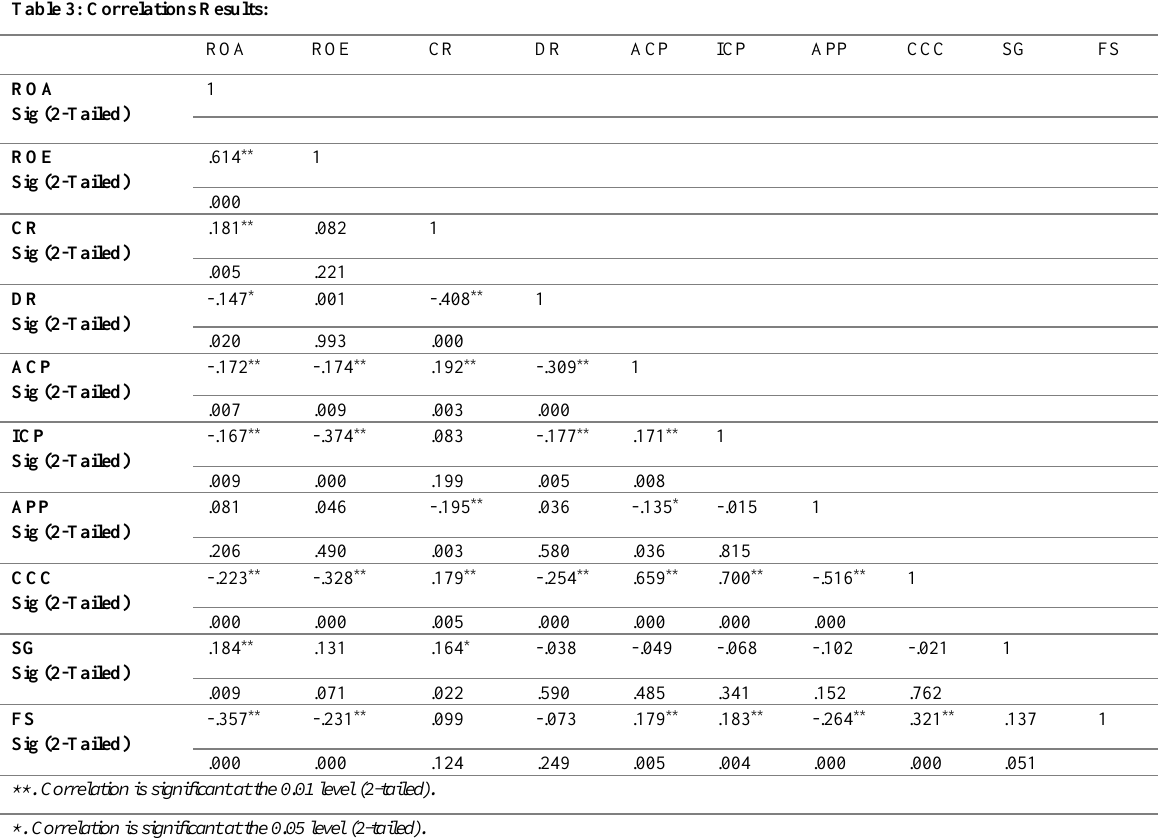
Table 3 : shows the correlation among different variables. Table 3: Correlations